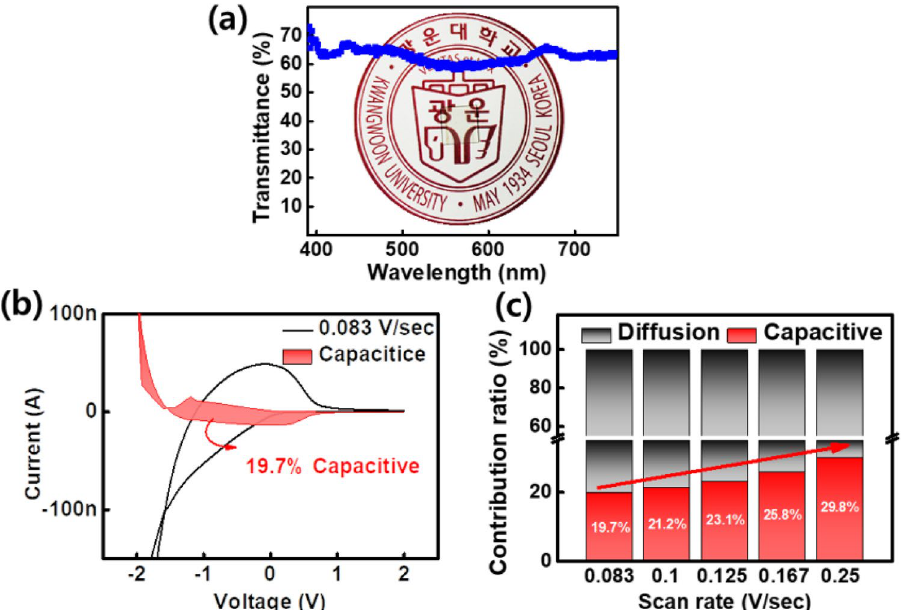
Figure 4. ( a ) Optical transmittance of T-SC device and the corresponding image (inset). ( b ) Capacitive and diffusion-controlled charge storage process at a scan rate of 0.083 V/s. ( c ) Contribution ratio of capacitive and diffusion-controlled currents at various scan rates of the T-SC